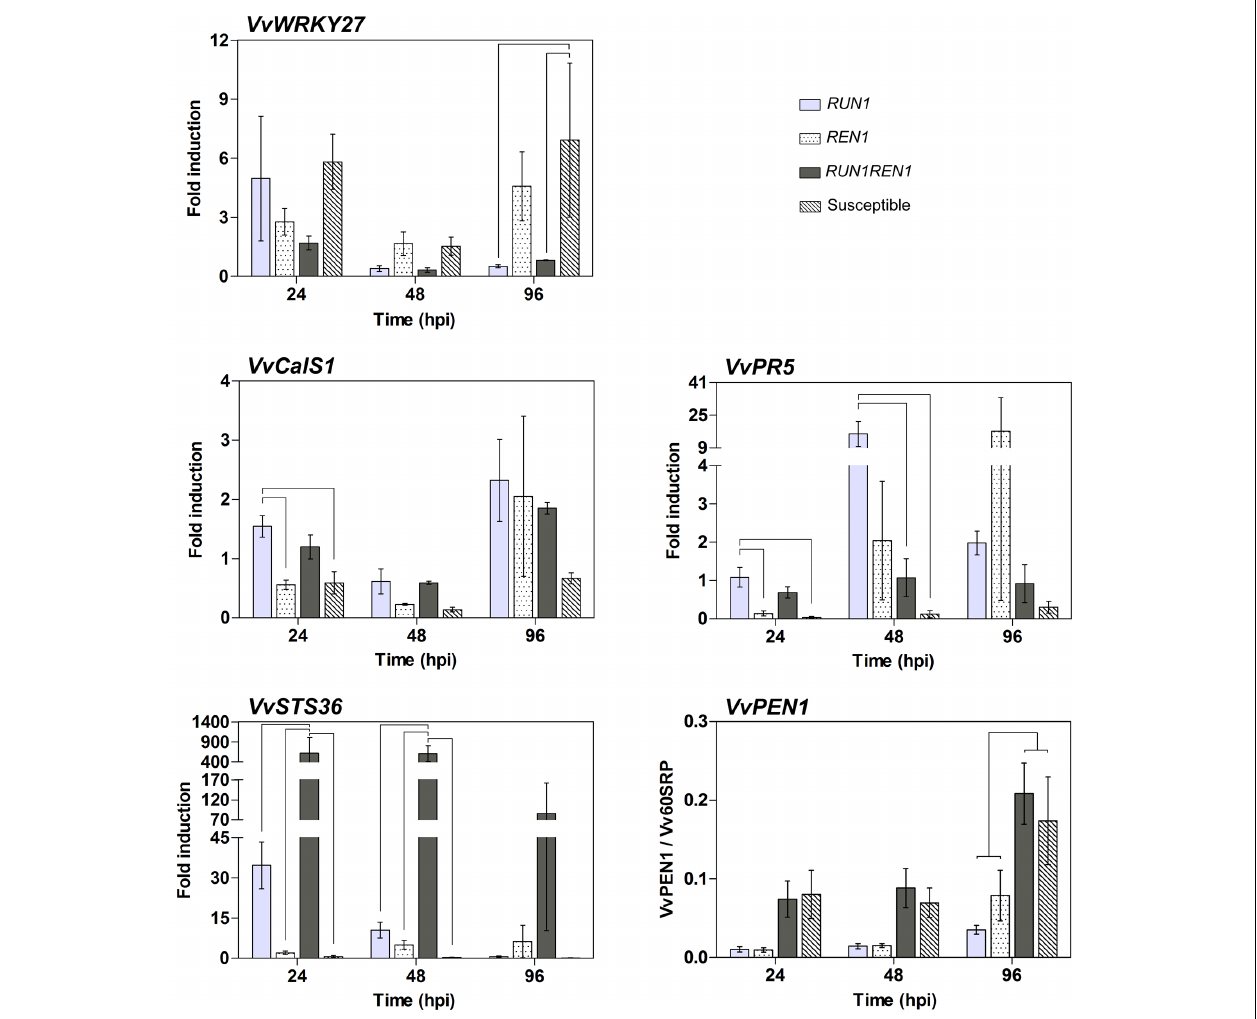
FIGURE 8 | RT-qPCR analysis of defense-related gene expression in response to E. necator . Samples were collected at 24, 48, and 96 hpi. Expression data were related to Vv60SRP housekeeping gene and/or normalized to uninfected controls (0 hpi). Data points represent means ± SEM considering three biological replicates. Linking lines shows statistically significant difference between genotypes as determined by Bonferroni’s multiple comparison test ( P ≤